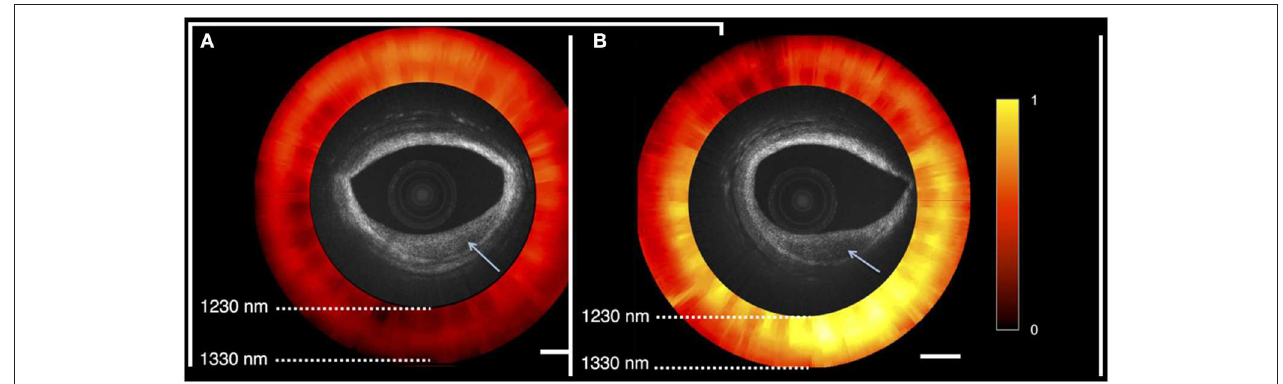
FIGURE 9 | OCT-NIRS images of cadaver coronary artery. Both OCT images show lesions with reduced backscattering (arrow). NIRS image (red and yellow) shows absorption spectra compatible with fibrotic tissue (red) in the left image (A) , and lipid-rich tissue (yellow) in the right image (B) . As shown on the right image, a promising feature of the combined OCT-NIRS device is that OCT may facilitate determining the depth of lipid cores identified by NIRS.